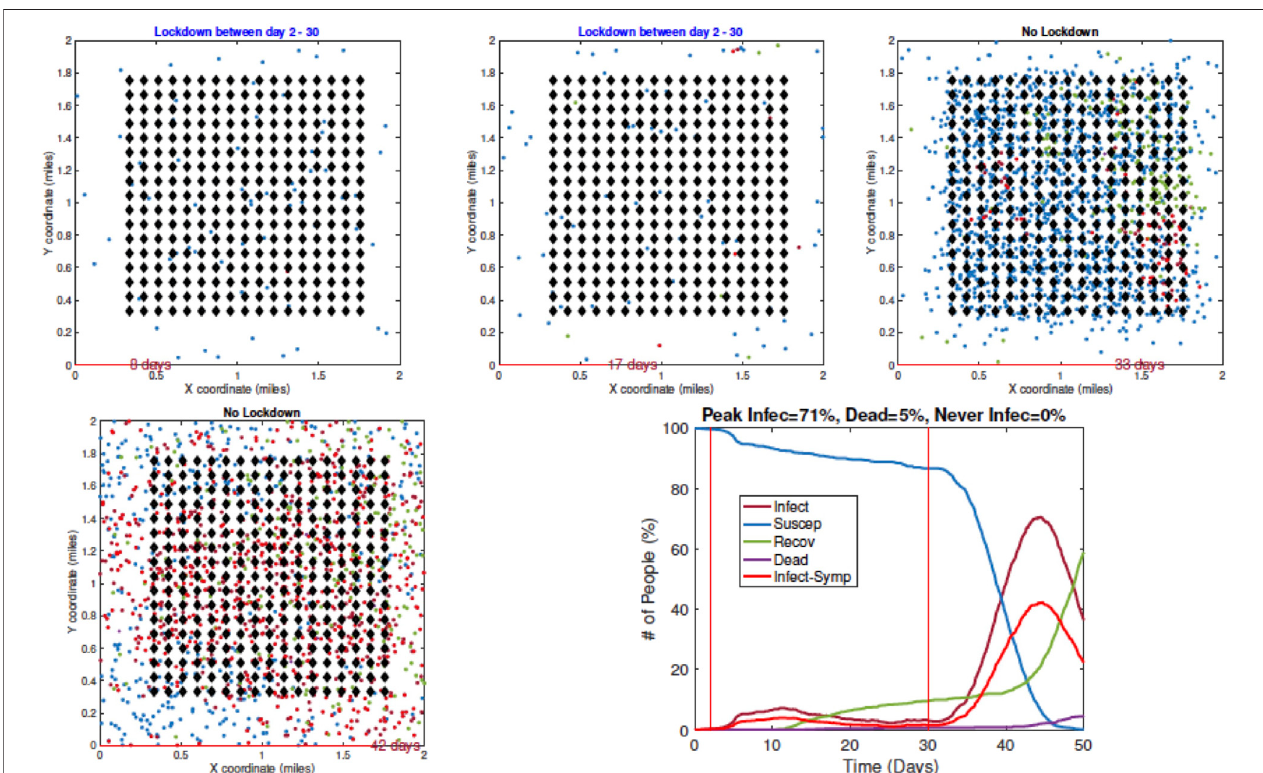
FIGURE 9 | Example 3: model outputs when a full lockdown or LD1 is imposed on Day 2 and removed on Day 30. As seen in the plot of the resulting pandemic curves, the infection is controlled at fi rst by the lockdown, but it spreads fast after the lockdown is